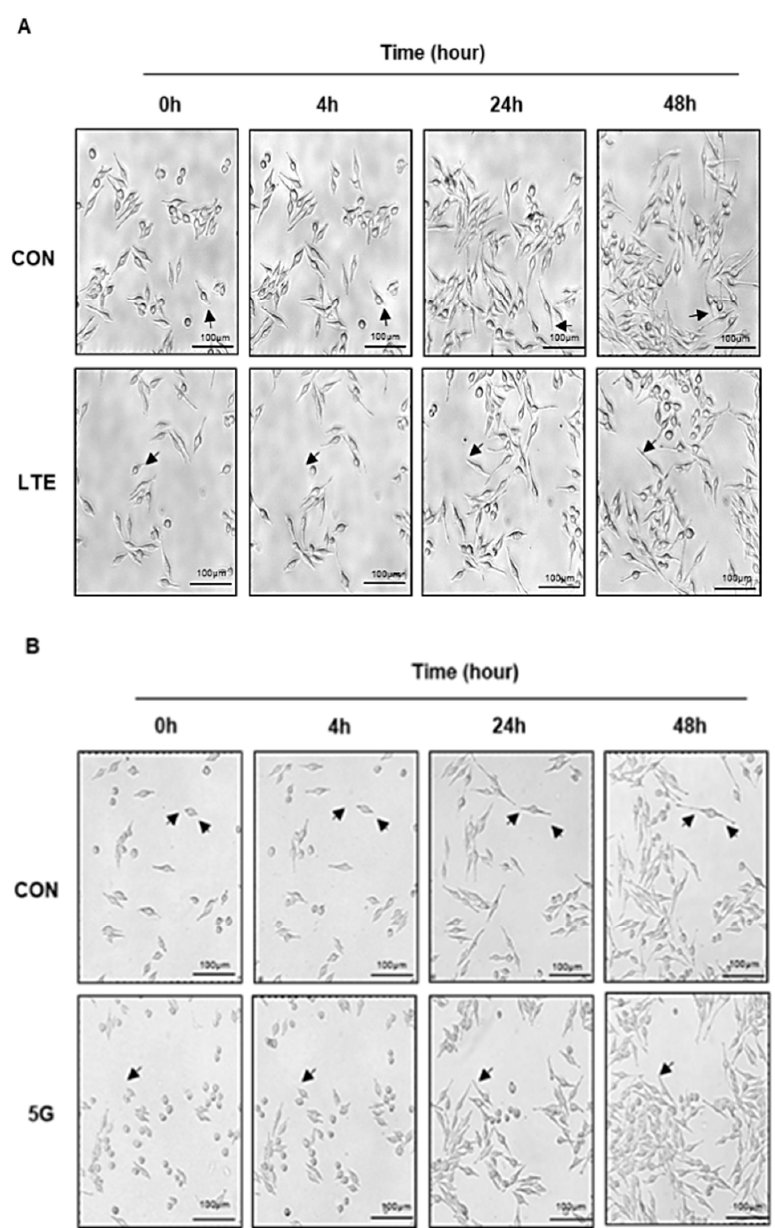
Figure 2. Effects of electromagnetic fields (EMFs) on the dendrite formation in MNT-1 cell lines. MNT-1 cells were exposed to either LTE (1.762 GHz) or 5G (28 GHz) for 4 h per day on indicated days. Morphological changes were observed under optical microscopy (100×). ( A ) Dendrite formation by MNT-1 cells after LTE (1.762 GHz) exposure. ( B ) Dendrite formation by MNT-1 cells after 5G (28 GHz) exposure. Black arrows indicated the representative dendrite formation as the cultivation time